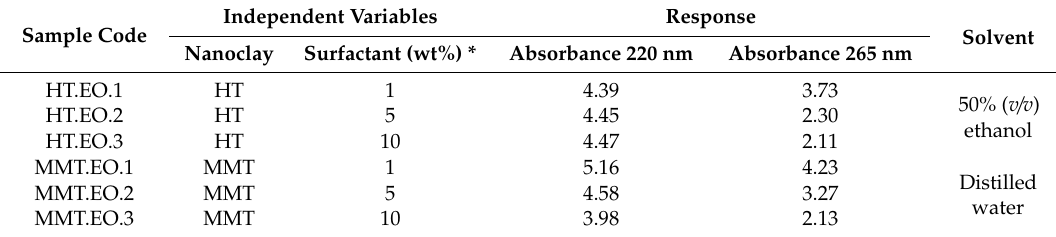
Table 3. 2 1 • 3 1 fractional experimental design matrix and responses obtained for lemon essential oil (LEO) adsorption at 100 wt%.